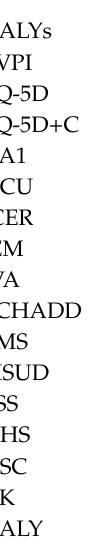
Table S1: Diagnosis resource use; Tables S2a–f: Management costs for GA1, IVA, HCU, LCAHDD and MSUD; Table S3a: Duration and costs of encephalopathy crises and episodes of intercurrent illness requiring preventive management; Table S3b: Frequency and annual costs of episodes of intercurrent illness requiring preventative management; Table S3c: Health and social care costs associated with neurological impairment / developmental delay; Figure S1: Cost-e ff ectiveness planes; Figure S2: QALYs in symptomatically and screen-detected